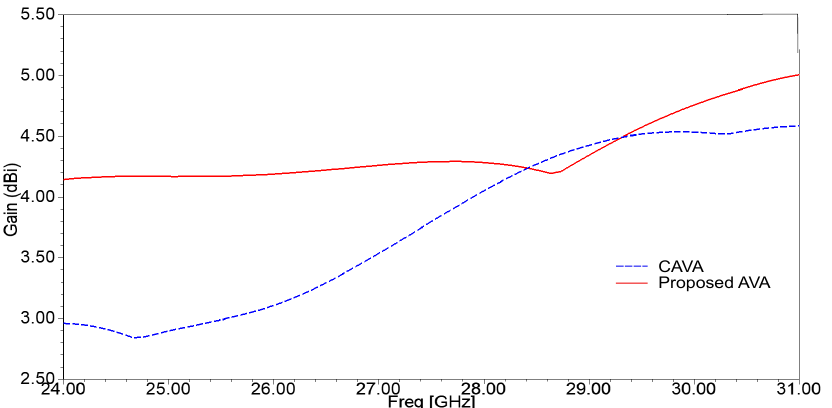
Figure 5. Gain versus frequency plot of the single-patch AVA with and without